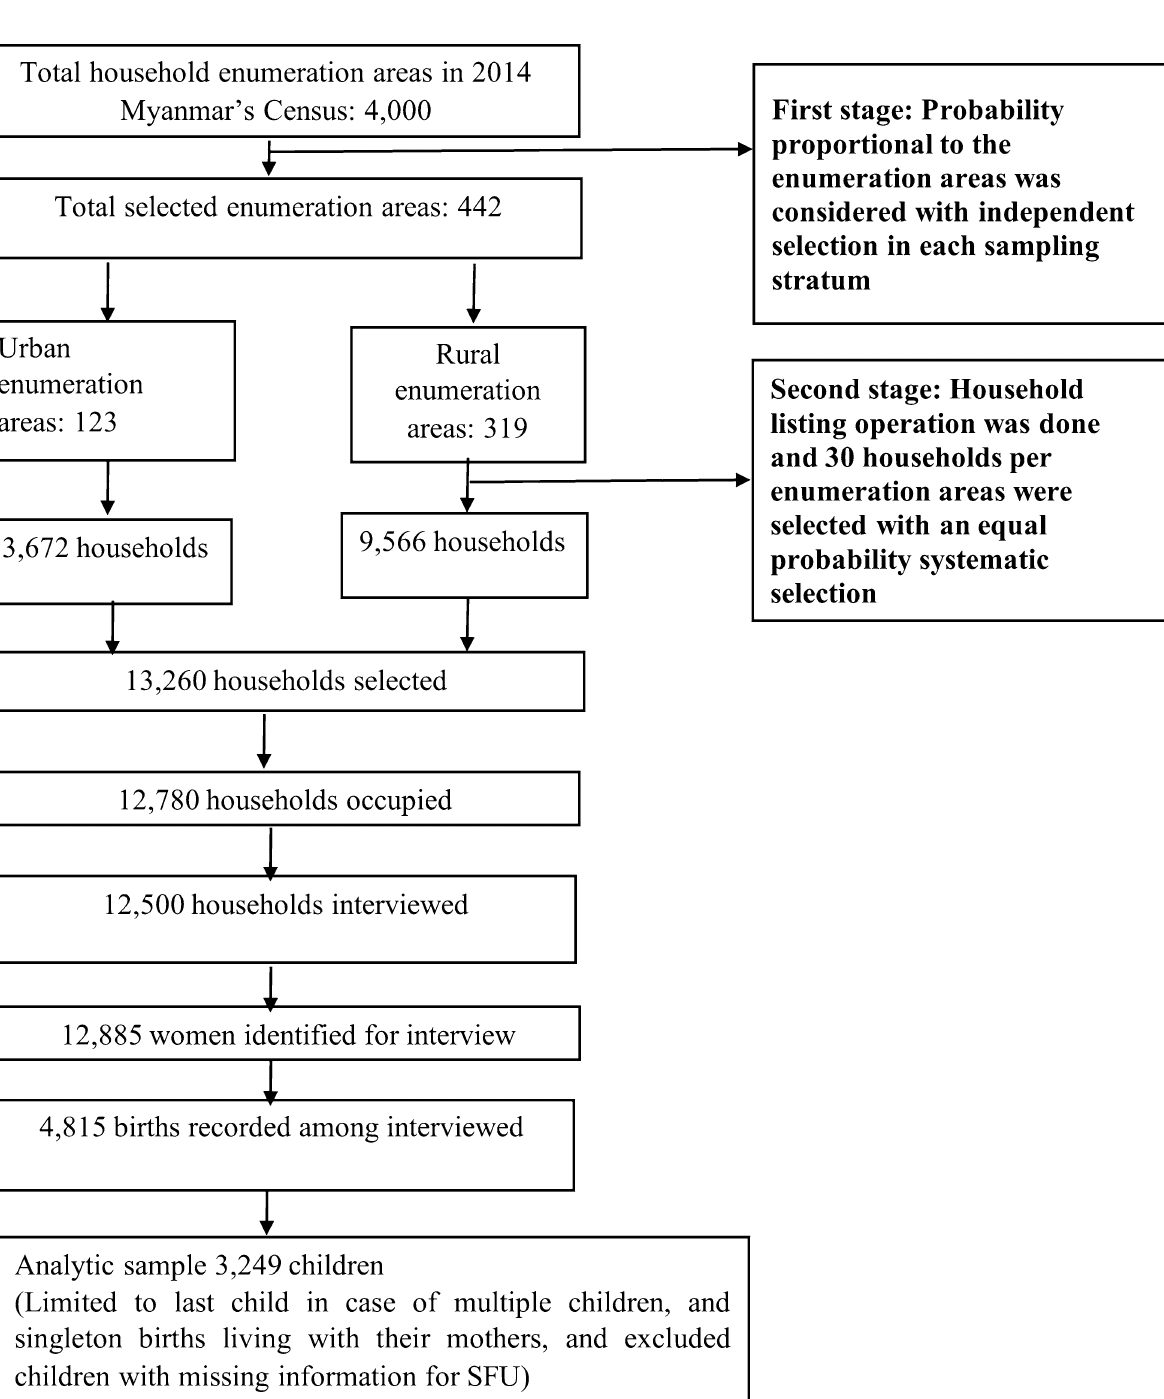
Figure 1. Schematic of the analytic sample selection process for child mortality in